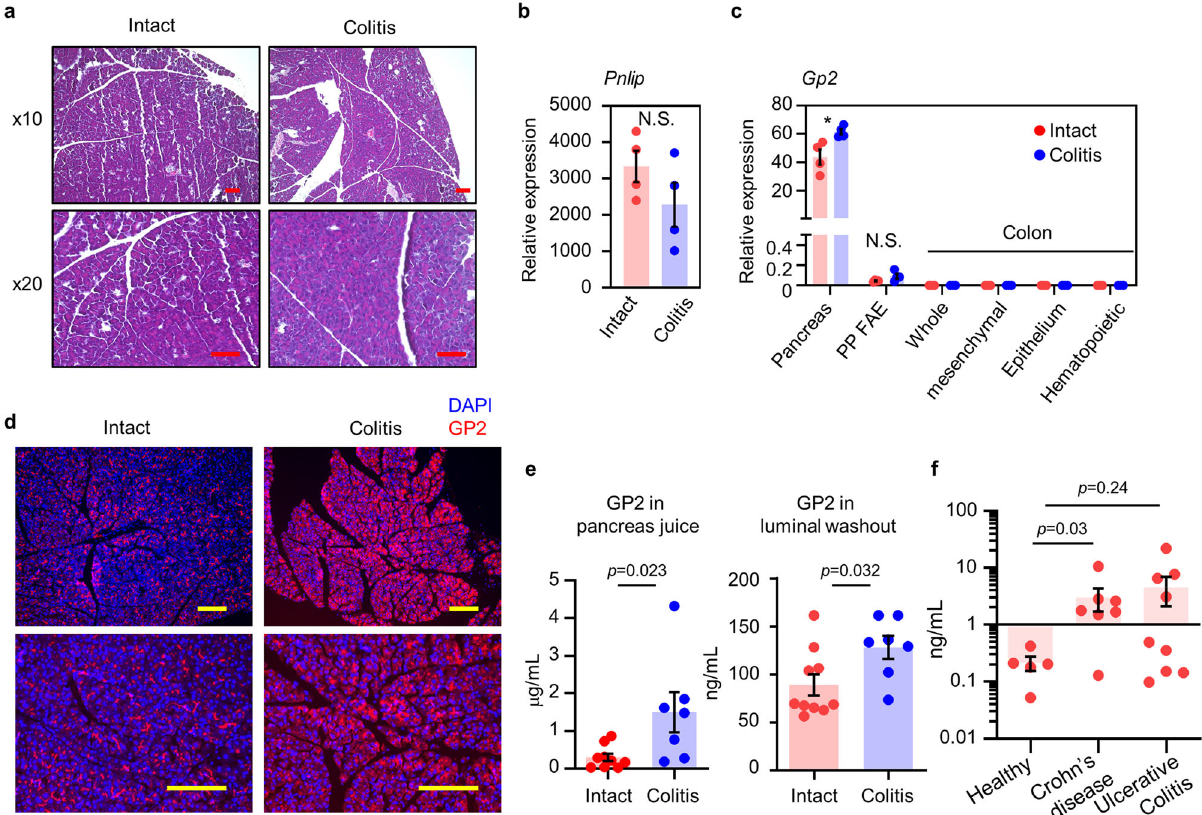
Fig. 2 Upregulation of pancreatic GP2 production in colitis. a Hematoxylin and eosin staining of pancreas in intact or colitis mice are shown. Scale bars, 100 μ m. Data are representative of at least three independent experiments. Gene expression of Pnlip in pancreas ( b ) and of Gp2 in the indicated tissue and cellular components of the gastrointestinal tract ( c ) in intact mice and mice with acute colitis ( n = 4/group, two-tailed unpaired t -test). * p = 0.021. Data are presented as mean values± SEM. N.S. indicates not signi fi cant. d GP2 expression in pancreas. Representative data of four independent experiments are shown. GP2 (red), DAPI (blue). Scale bars, 100 μ m. e Concentrations of secretory GP2 in pancreatic juice and intestinal lumen, as measured by enzyme- linked immunosorbent assay (ELISA) (intact, n = 10; colitis, n = 7, two-tailed Mann – Whitney U test). Data are presented as mean values ± SEM. f Fecal GP2 concentration was determined by ELISA and compared between healthy people ( n = 5), CD patients ( n = 7), and ulcerative colitis patients ( n = 9), two-tailed Mann – Whitney U test. Data are presented as mean values ± SEM. Source data are provided as a Source Data fi